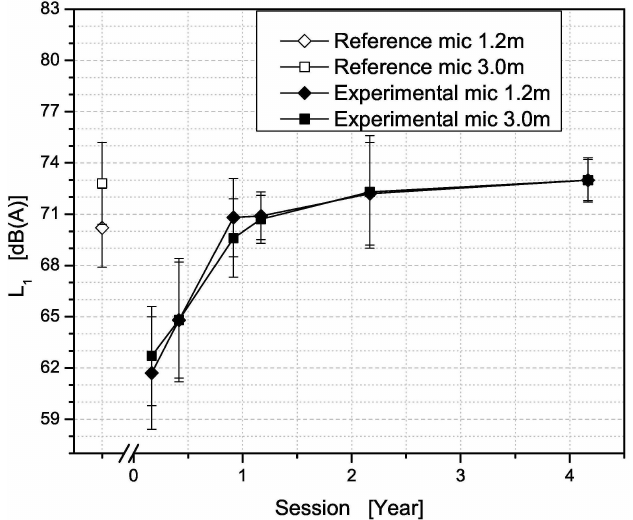
Figure 13. Time evolution of SPB values in Site 4. In white ante-operam values.